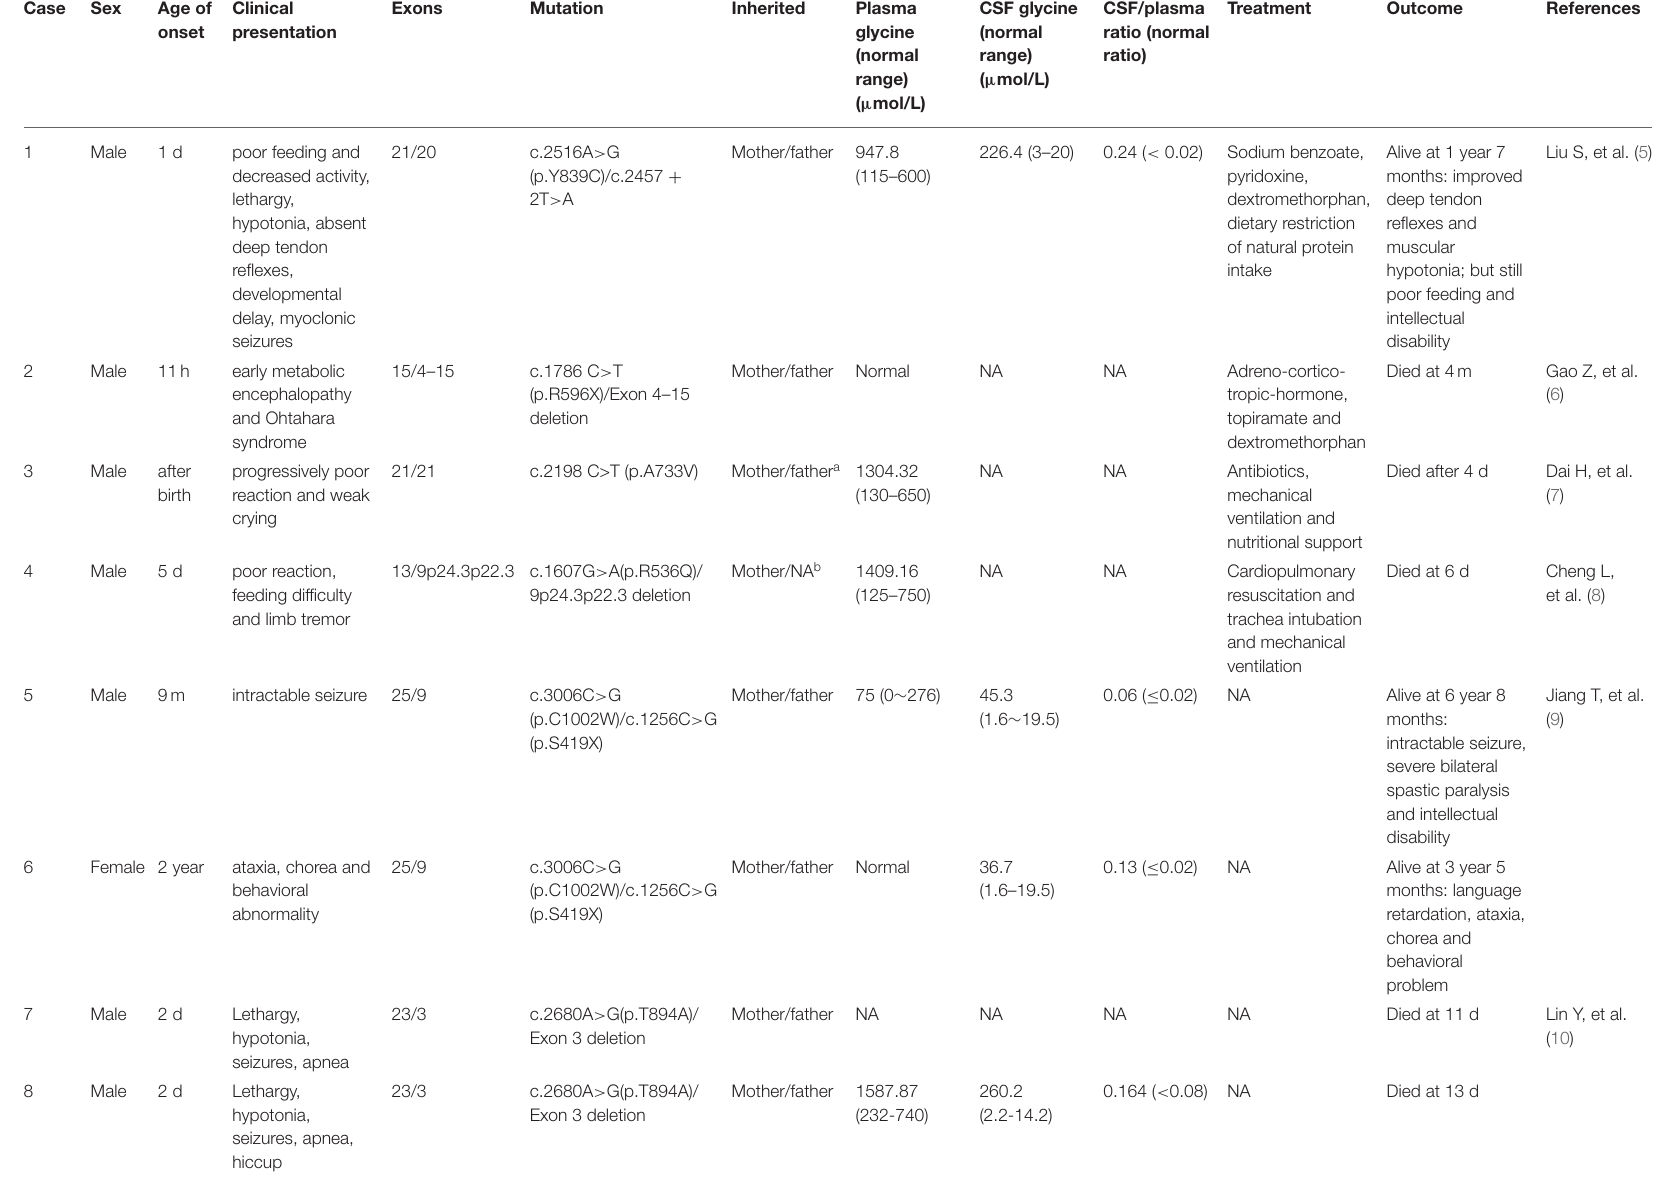
TABLE 1 | Clinical characteristics and GLDC variants in Chinese NKH